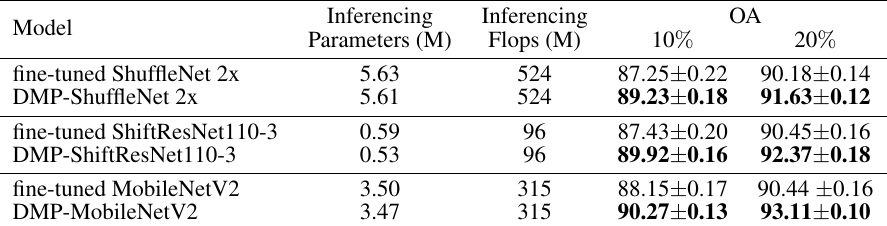
Table 3. Performance improvement of ShuffleNet, ShiftResNet110-3 and MobileNetV2 on NWPU-RESISC45 data set.